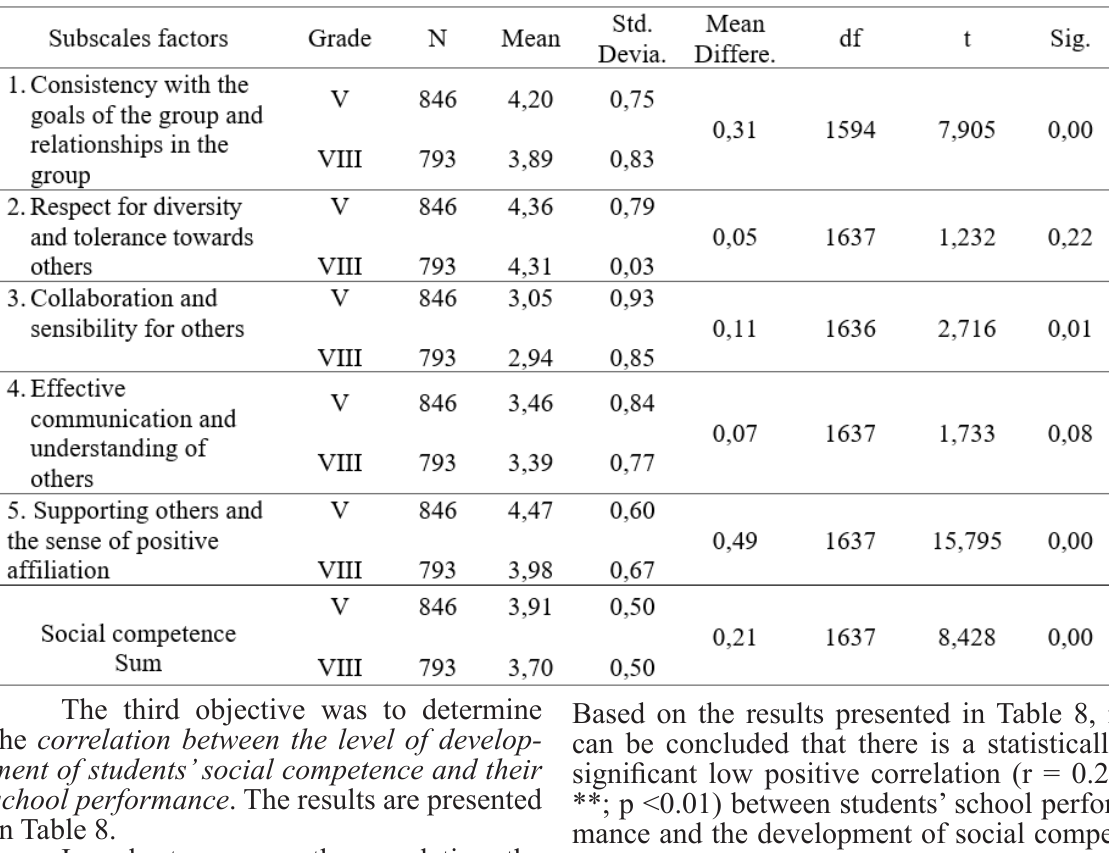
Table 7. Differences in assessments of the development of social competence with regard to the students' grade